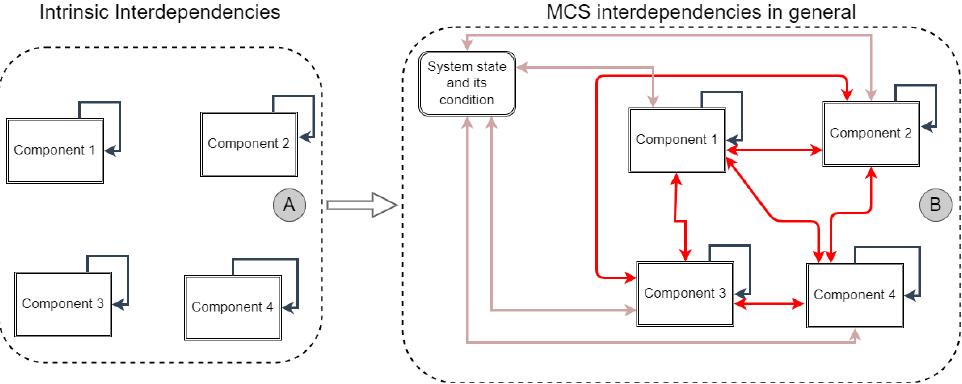
Figure 1. In section A, the intrinsic interdependencies on the components are shown. This type of interdependencies is assumed and taken into account in referenced research work [10]. Whereby, in section B, along with intrinsic interdependencies, also interdependencies with other components and system state and its condition are